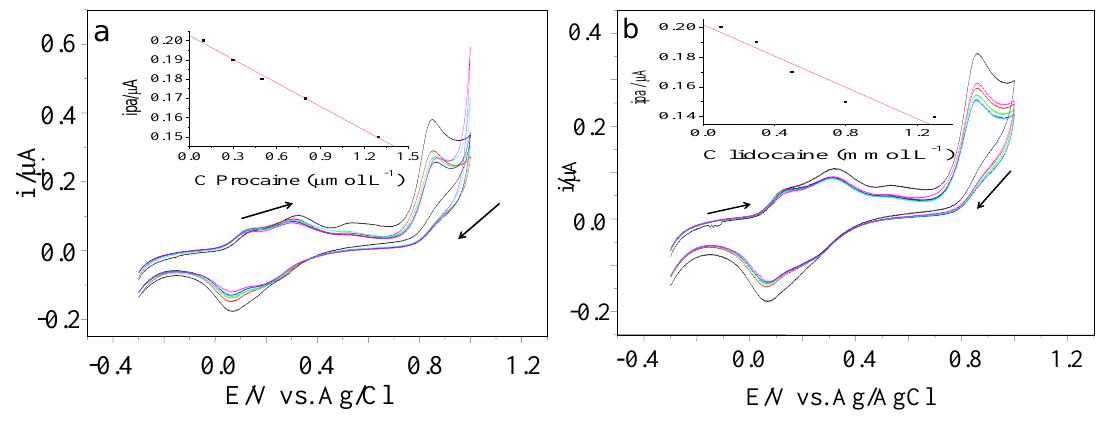
Figure 5. Influence of the concentration of procaine ( a ) and lidocaine ( b ) standard samples on the electrochemical response of the electrode modified